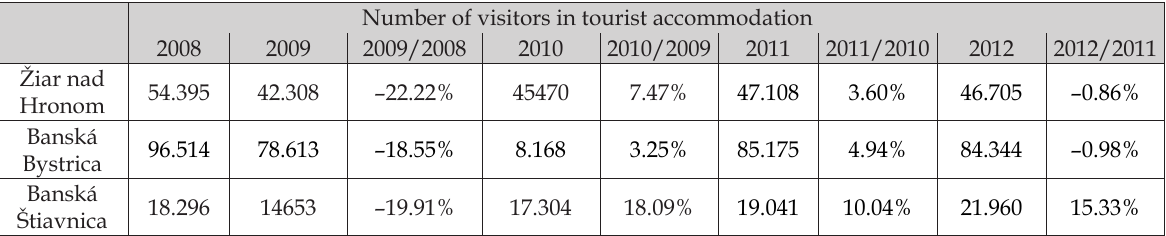
Table 2. Number of visitors in tourist accommodation and its change,